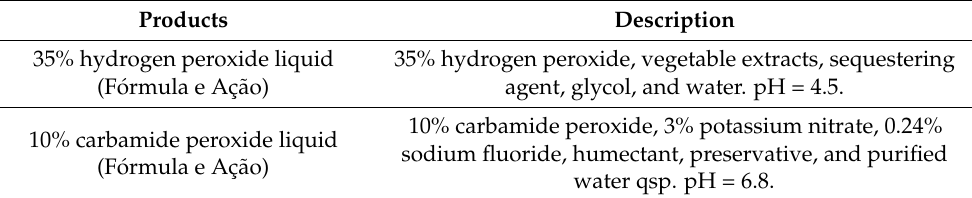
Table 3. Characteristics of 35% HP liquid and 10% CP liquid. Products Description 35% hydrogen peroxide